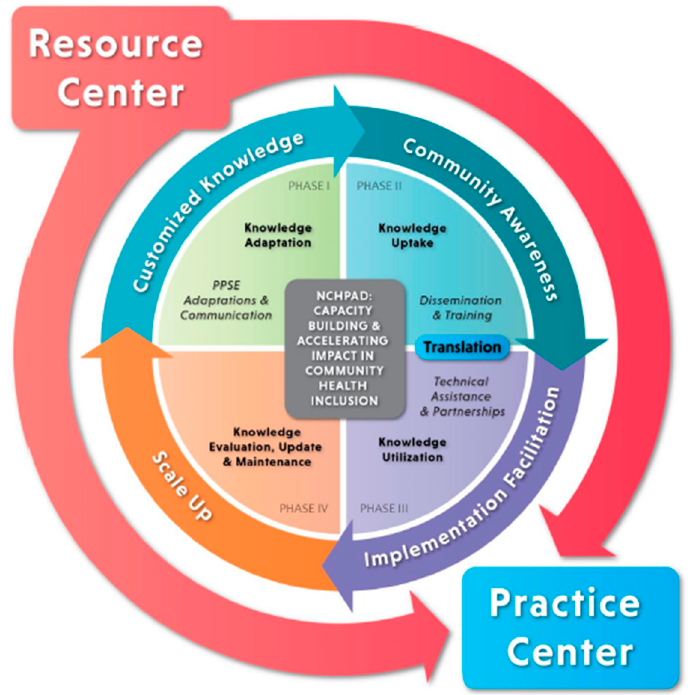
Figure 1. The National Center on Health, Physical Activity, and Disability Knowledge Adaptation, Translation, and Scale-up Framework.